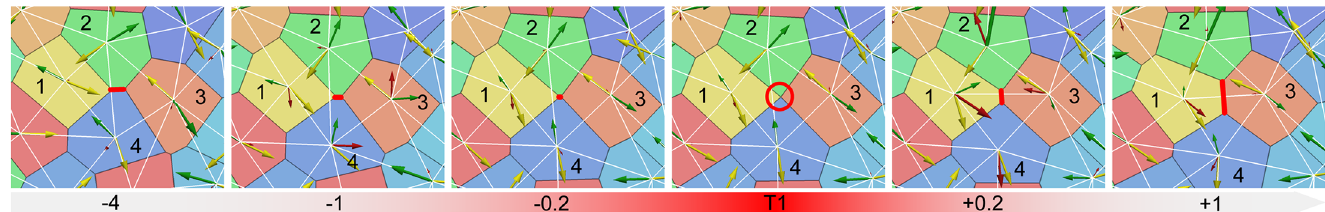
Fig 5. Time lapse of a T1 transition, each label is the time (in units of γ / Ka 2 , with a = 1) with respect to the T1 event. Initially, cells 2 and 4 are in contact (red line). Approachingthe transition, the connectingline slowlycontracts, until it becomes a point at the transition. Cells 1 and 3 make a new contact which then rapidly expands.The arrows represent the force on the cell centre resultingfrom the Vertex potential(green), which partially compensates the active self-propulsionforce (yellow)to give the resultant total force (red). The Voronoitessellationis outlinedin black, and the Delaunay triangulation is in